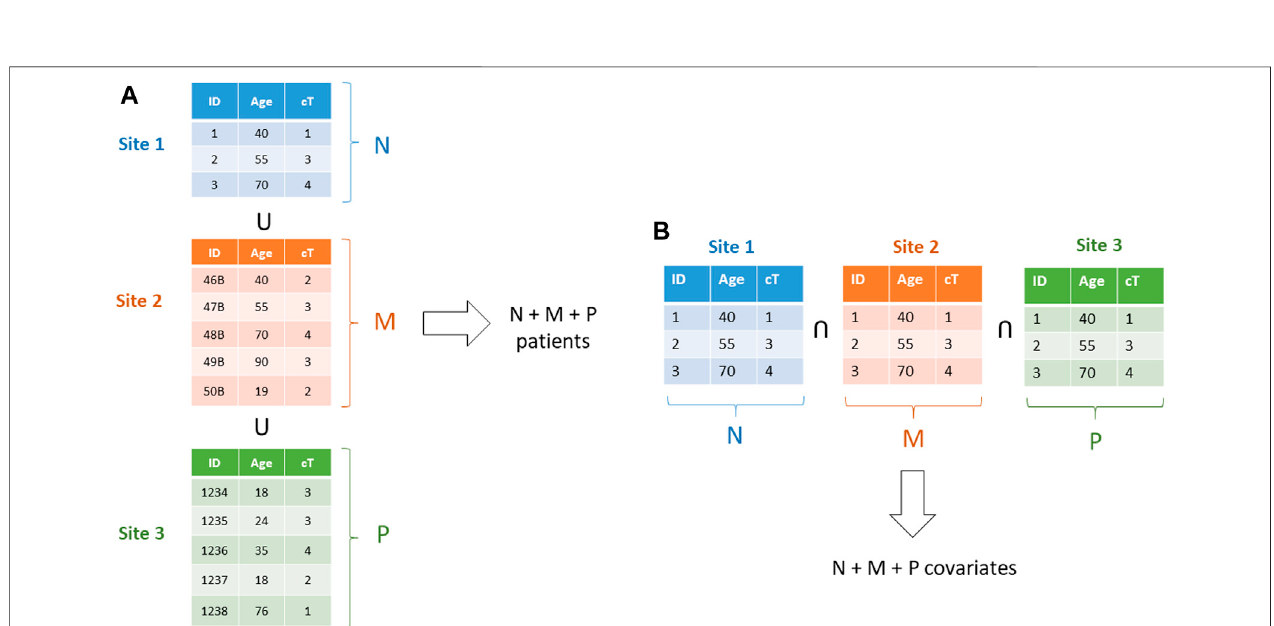
FIGURE15|(A) – Ahorizontally partitioneddataset: eachoneofthethreedatasetsincludesfullpatients.b) – avertically partitioneddataset: eachinstitutionincludes a subset of the covariates for all patients.